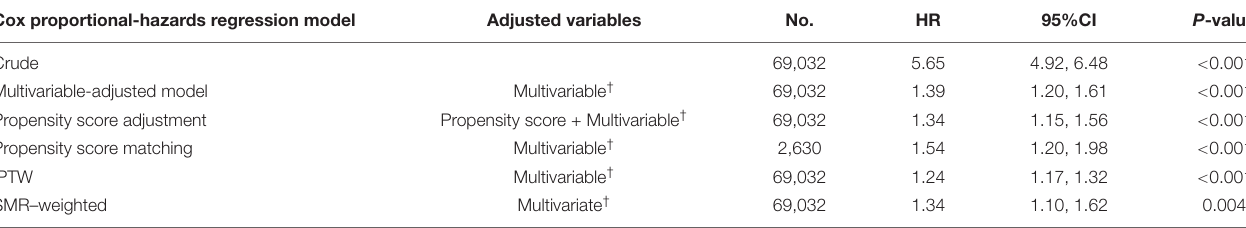
TABLE 2 | Associations between CHF and one-year postoperative mortality of surgical patients in the crude analysis, multivariable analysis, and four propensity-score methods analyses. Cox proportional-hazards regression